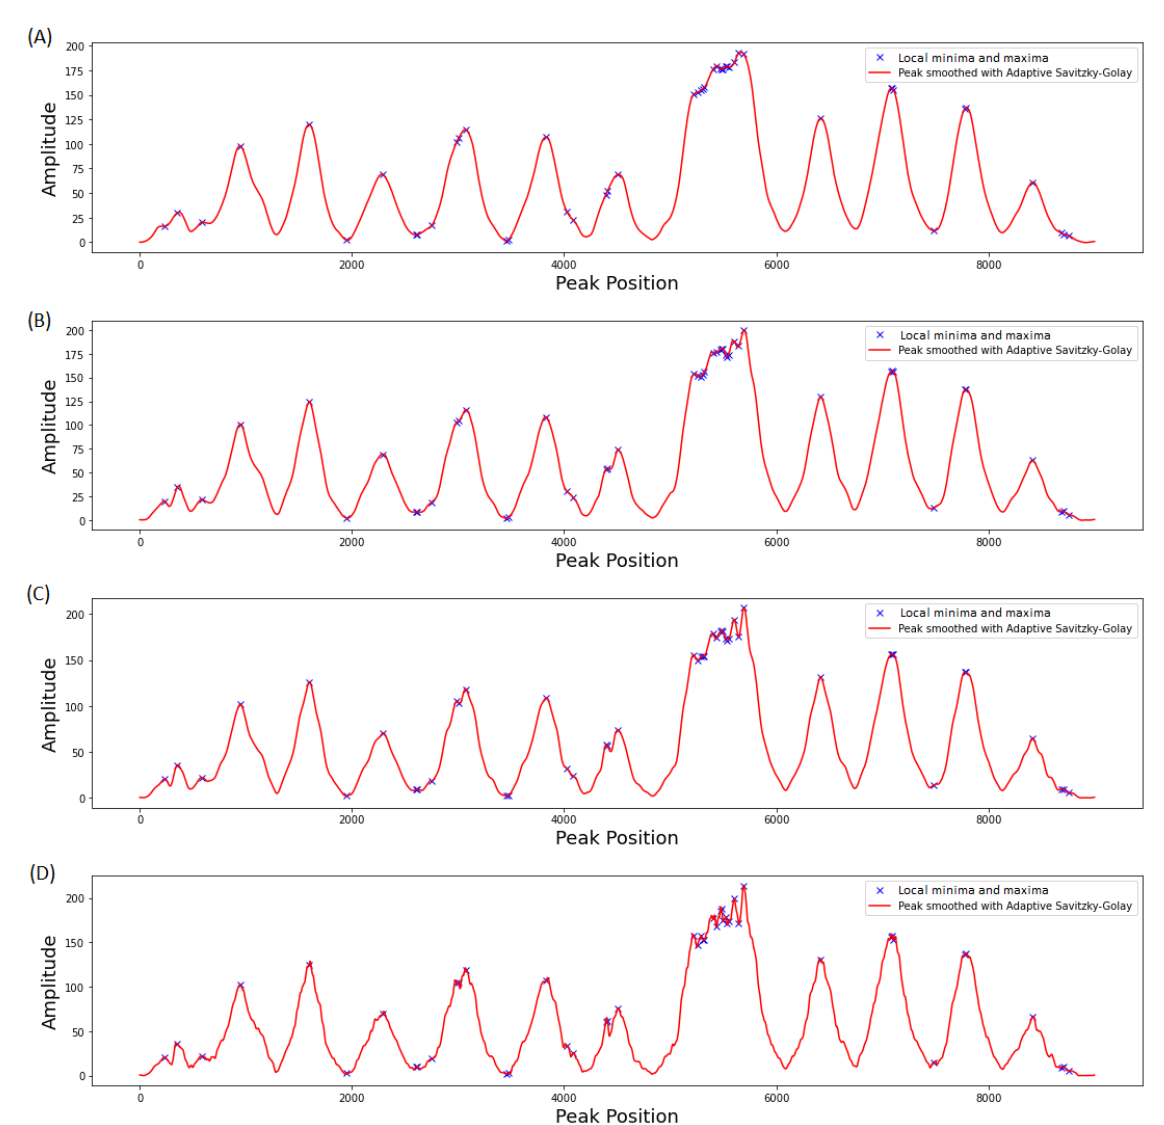
Figure 4. Detection of local minima and maxima peak heights with Adaptive Savitzky–Golay. ( A ): SG filter k 1 = 2, m 1 = 253. ( B ): SG filter k 2 = 3, m 2 = 201; ( C ): SG filter k 3 = 4, m 3 = 153. ( D ): SG filter k 4 = 5, m 4 = 51. Solid red line is the smoothed peak and blue stars are local minima and